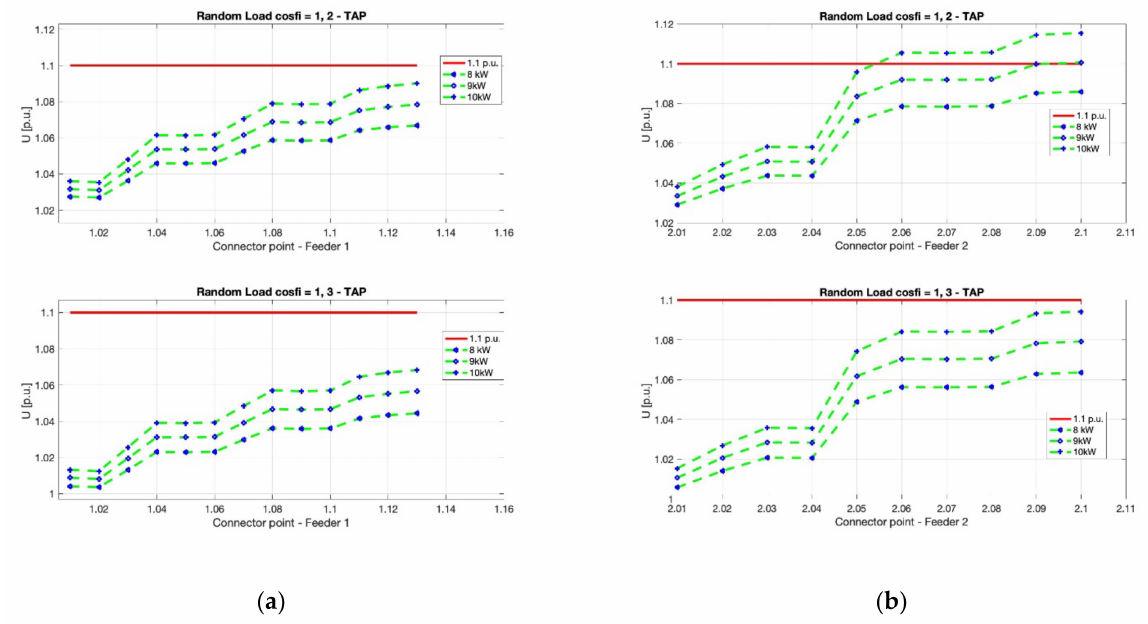
Figure 6. Scenario R, power factor = 1, TAP-2 and 3, Feeder 1—( a ) and Feeder 2—( b